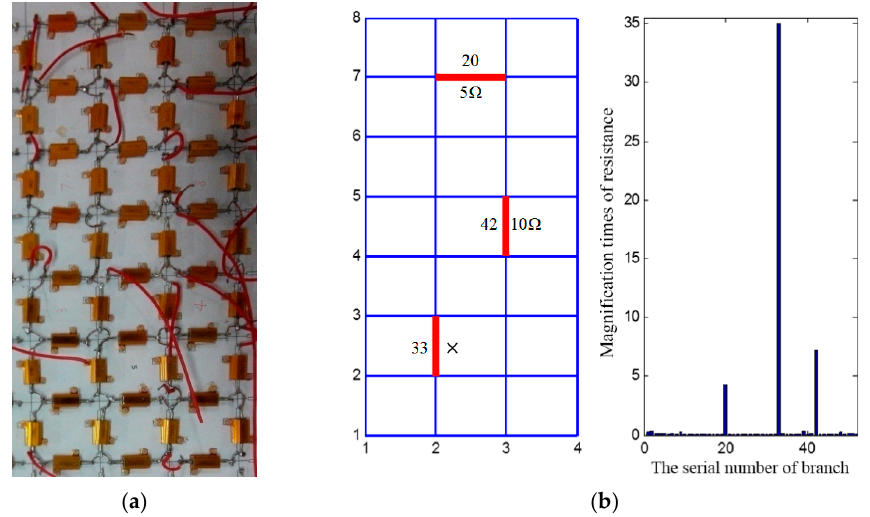
Figure 11. The results of the multiple branch fault case with a real resistance network. ( a ) Resistance network; ( b ) Diagnosis result.